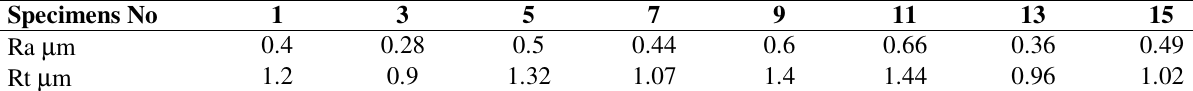
Selective surface roughness results of 8 specimens. Specimens No